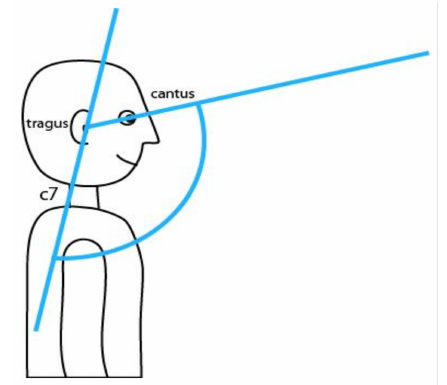
Figure 2. Illustration of craniocervical angle.